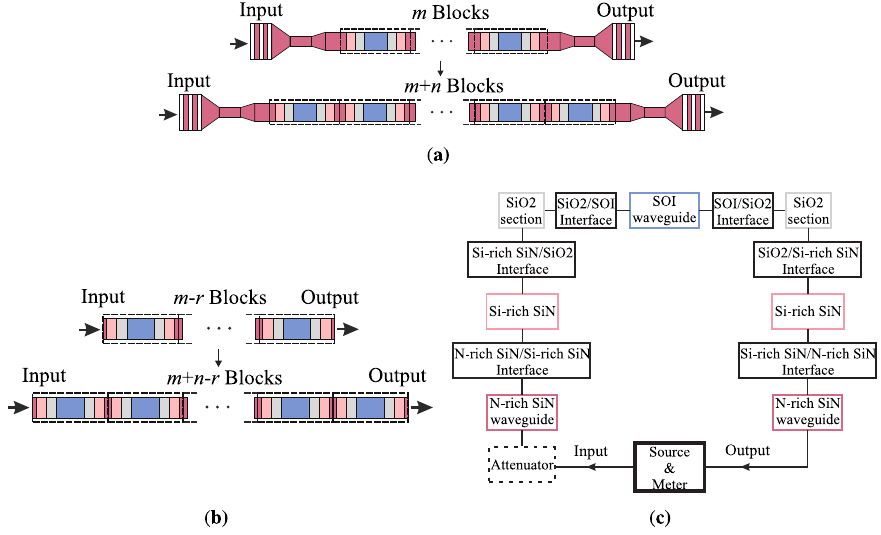
Figure 6. Top view of the cut-back devices (a) in their designed form including the I/O parts and (b) after their normalisation with a device of reference that contains r blocks. Each device is composed of a number of repeated blocks, that after normalisation is reduced by r . The block appears enclosed in the dashed frame and is composed of two N-rich SiN, two Si-rich SiN, two SiO 2 and one SOI sections. In (c) the block diagram used for the modelling of one block is depicted.